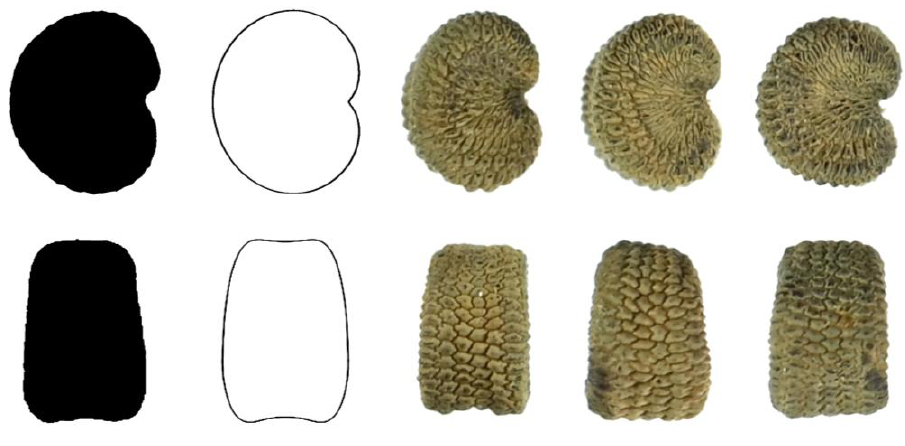
Bar represents 1 mm.